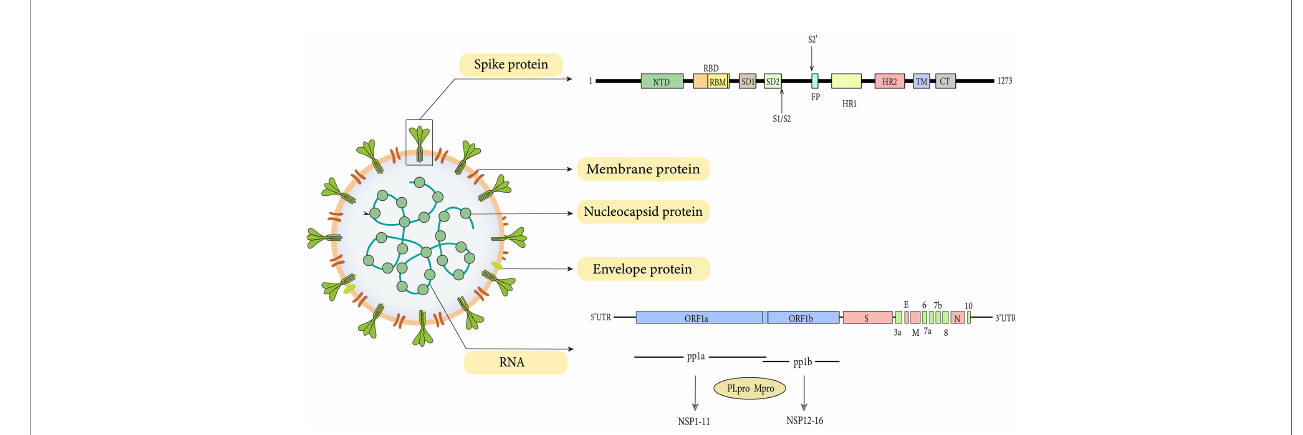
FIGURE 1 | Genome and structure of